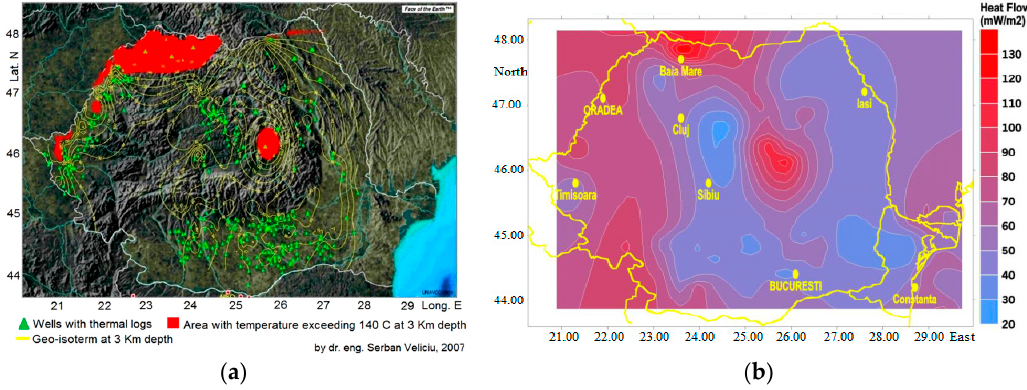
Figure 5. Position of the geothermal reserves in Romania [26] ( a ) Map of high temperature reserves; ( b ) Terrestrial heat flow map of Romania.